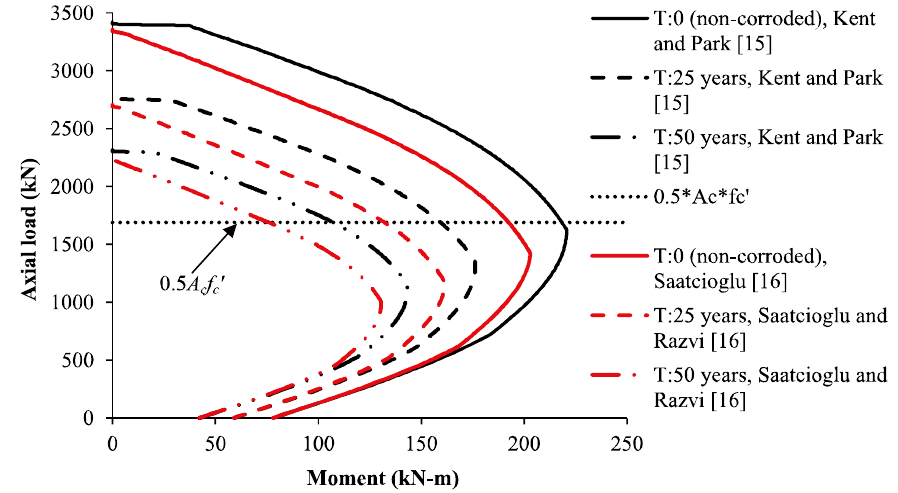
Fig. 6. Time-dependent M-N